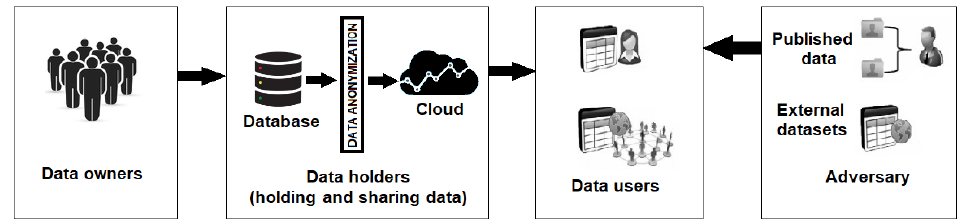
Figure 1. An overview of privacy-preserving data publication and adversarial